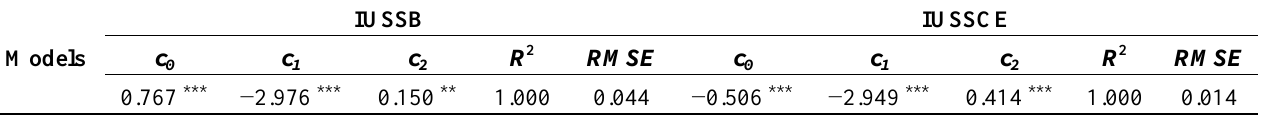
Table 4. Coefficients of vapor pressure fitting models for time dummy variables σ number of asterisks ( * ) indicate different significance levels ( p ): 1 = p < 0.05, 2 = p < 0.01, 3 = p < 0.001.